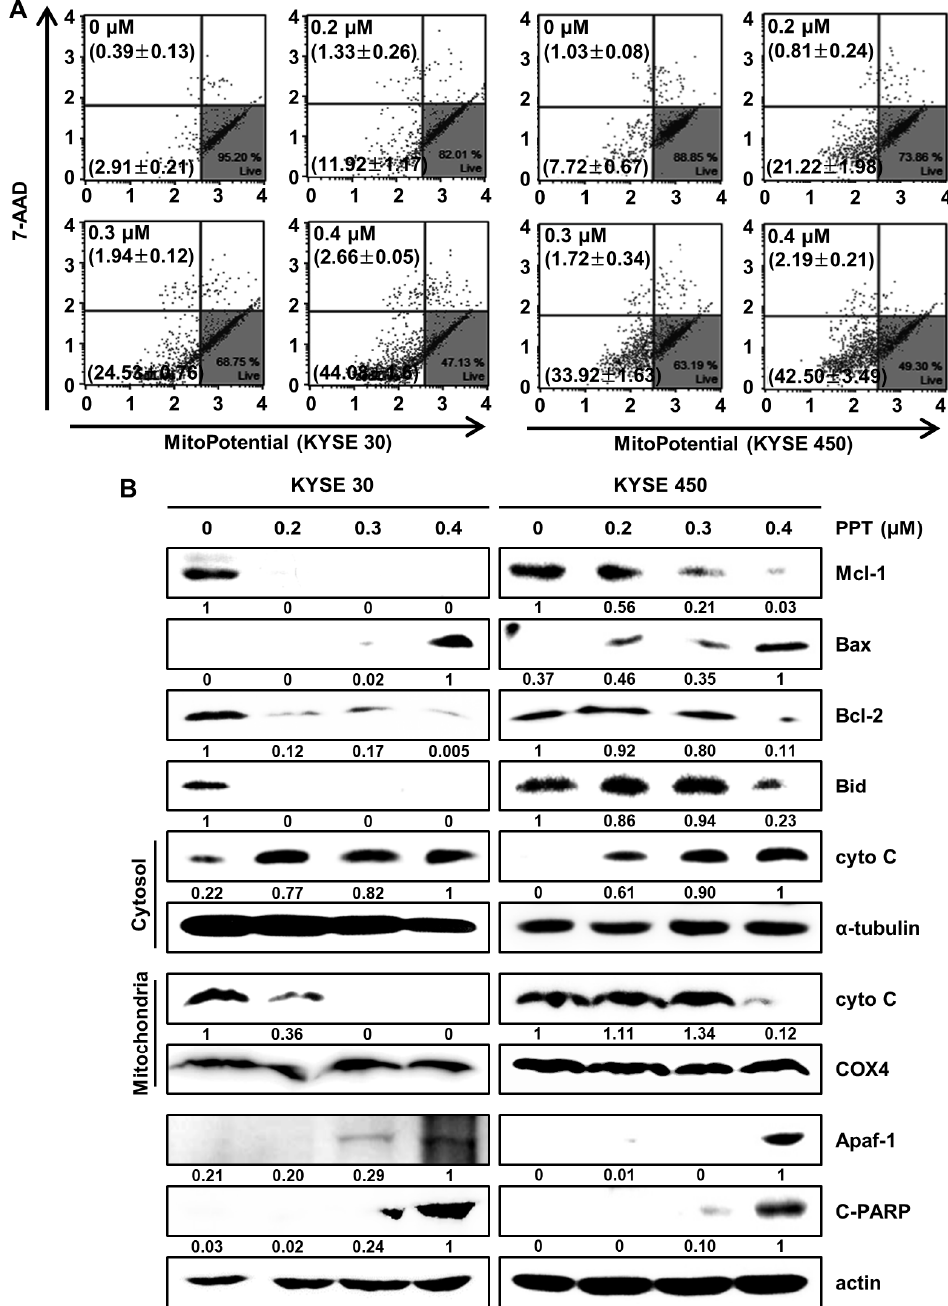
Figure 5. PPT alters mitochondrial membrane potential (MMP; ∆ ψ ) levels and induces apoptosis by regulating apoptosis-associated protein in ESCC cells. KYSE 30 and KYSE 450 were treated with PPT (0, 0.2, 0.3, and 0.4 µ M) for 48 h. ( A ) The Muse ™ MitoPotential Reagent (Merck Millipore) dye-stained cells were analyzed for the loss of MMP using a Muse ™ Cell Analyzer (Merck Millipore). ( B ) The total proteins were quantitated and the expression of Mcl-1, Bax, Bcl2, Bid, cyto C (cytosol and mitochondria), α -tubulin, COX4, Apaf-1, and C-PARP detected by Western blots. The expression of actin was employed as an internal